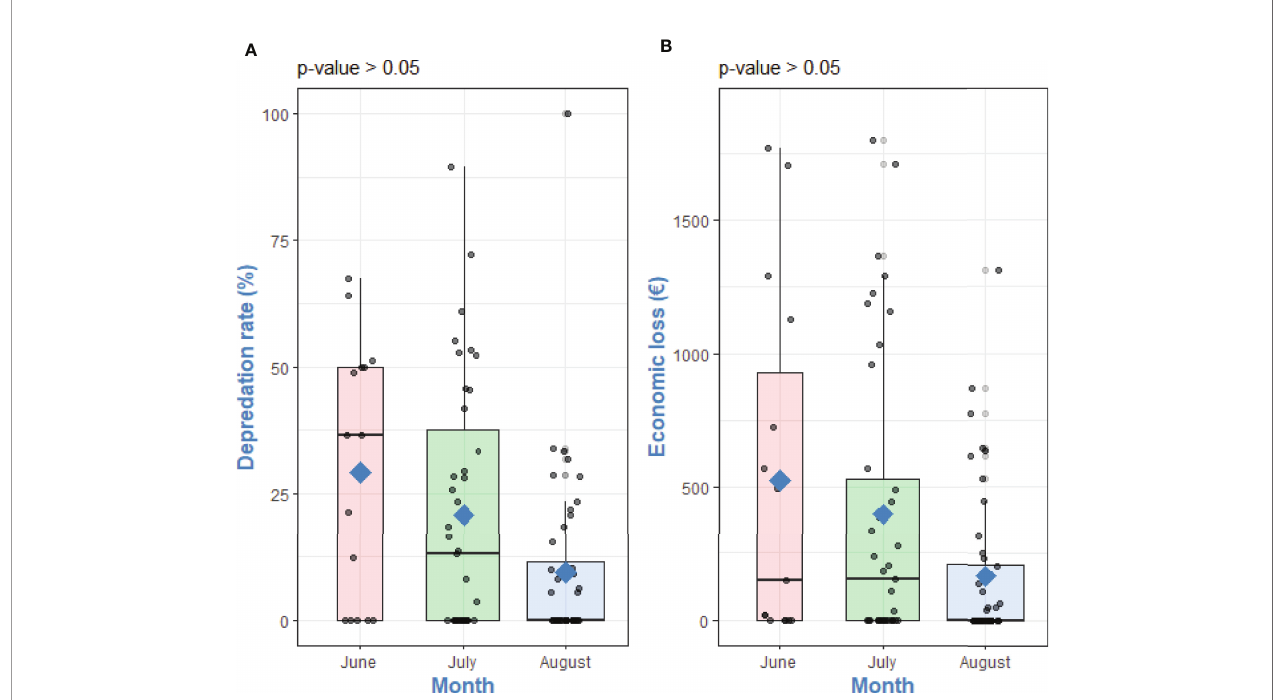
FIGURE 4 | Differences between (A) Depredation rate (%) and (B) Economic loss ( € ) and with month of fi shing. Kruskal-Wallis tests p- values. Points are raw survey data. Rhombuses represent the mean of each group.